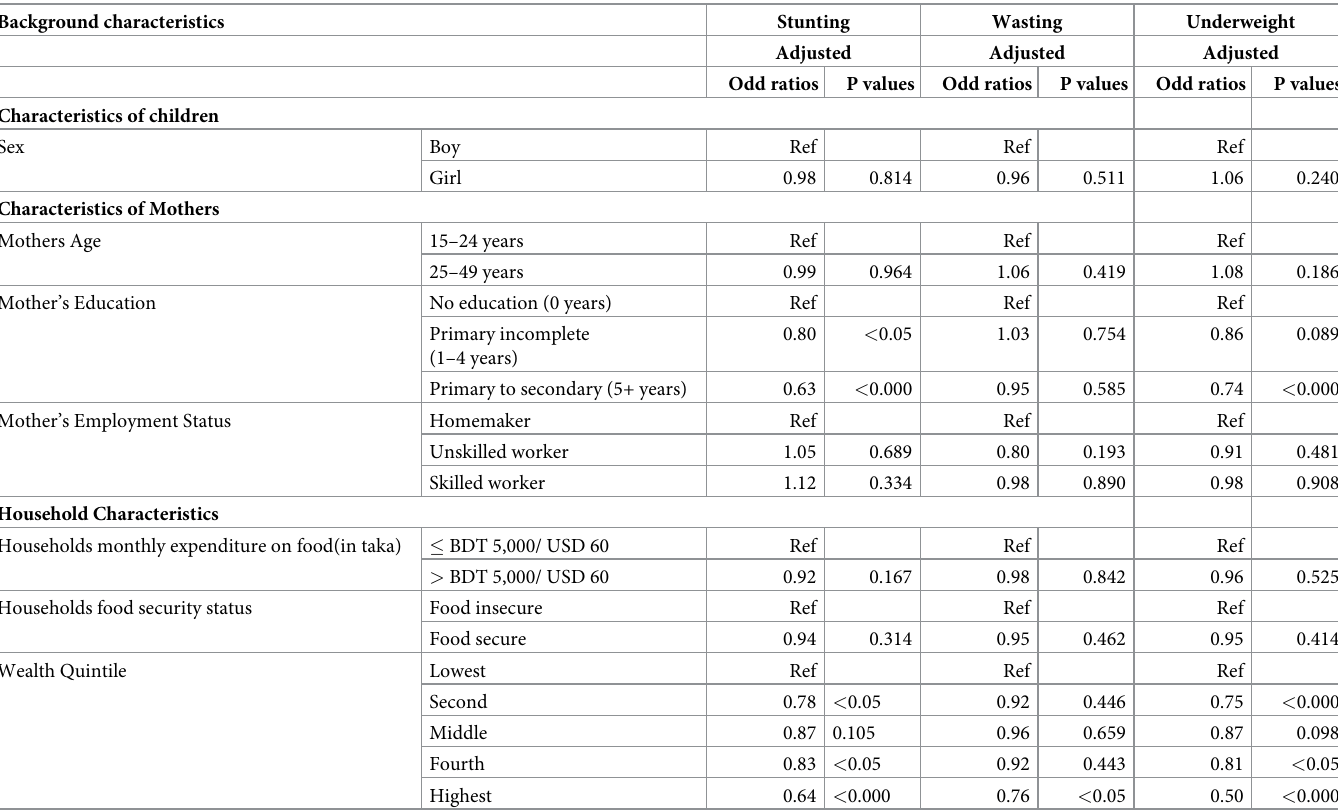
Table 4. Association of food security and socioeconomic factors with nutritional status of the children aged 6-59months in rural areas of Bangladesh, 2014. Background